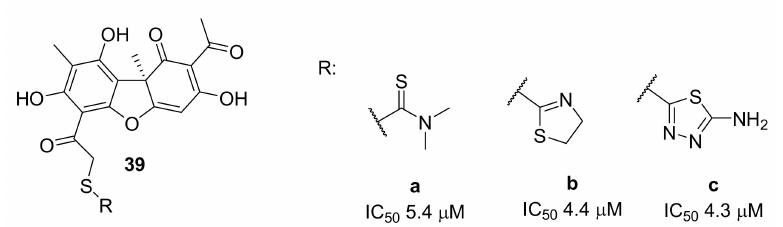
Figure 11. Usnic acid thioether derivatives as TDP1 inhibitors.